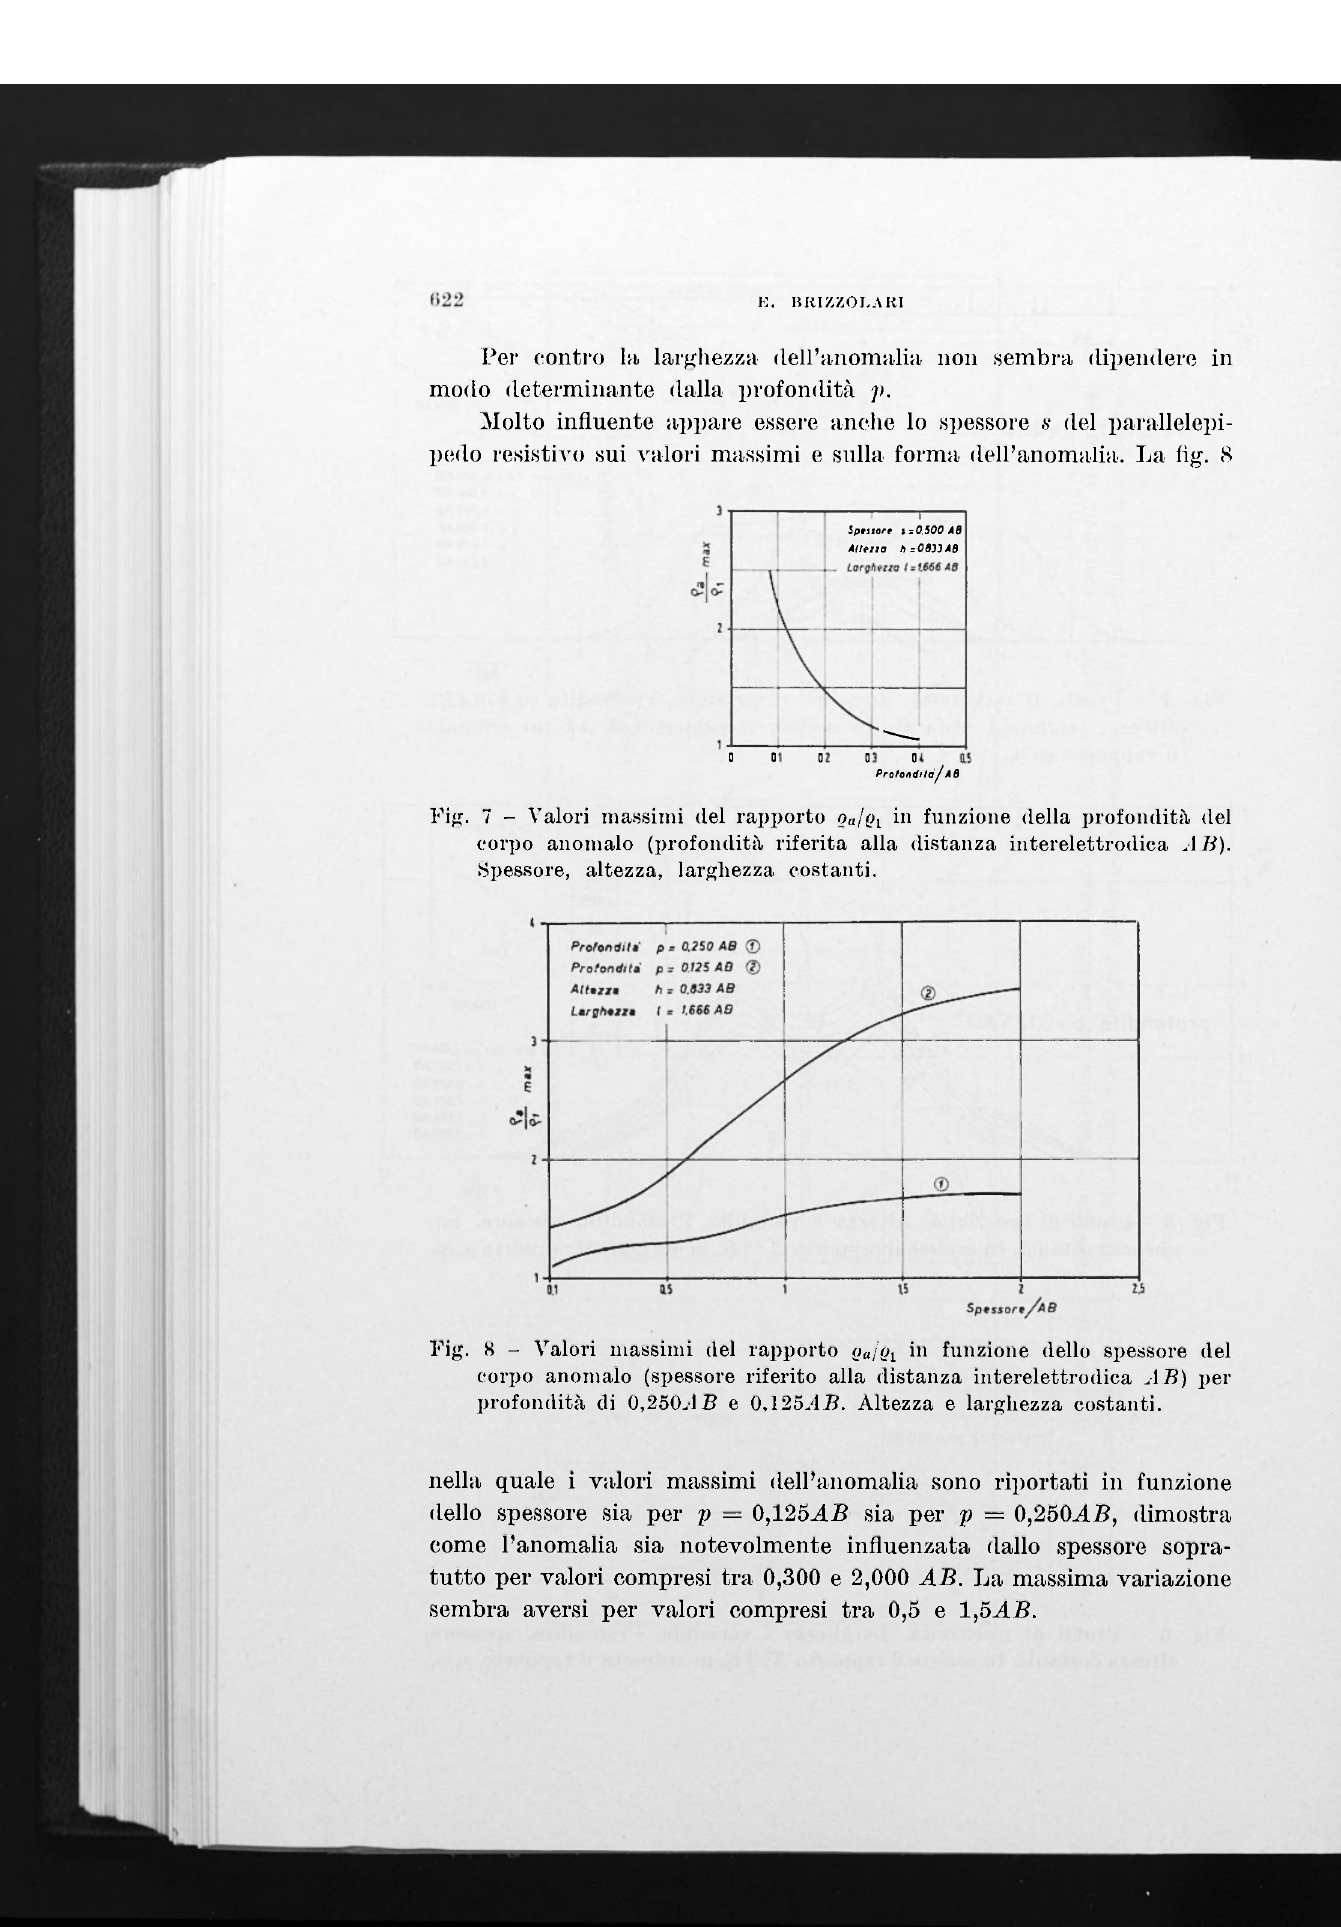
Fig. 8 - Valori massimi del rapporto QalQi in funzione dello spessore del corpo anomalo (spessore riferito alla distanza interelettrodica AB) per profondità di 0,250 AB e 0,125.4 B. Altezza e larghezza